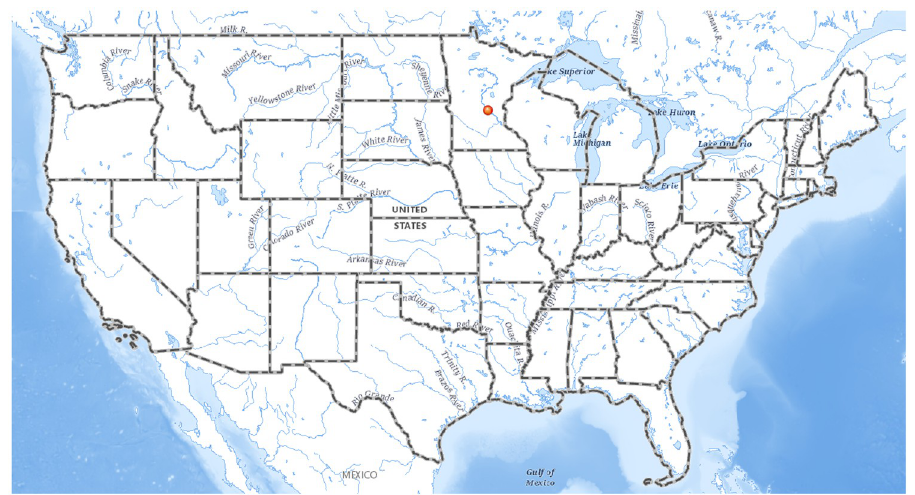
Fig 1. Study site map. The location of Briggs Lake is marked by a red dot. Map generated using USGS The National Map: National Hydrography Dataset. Data refreshed January, 2022 | USGS The National Map: National Boundaries Dataset. Data refreshed April,